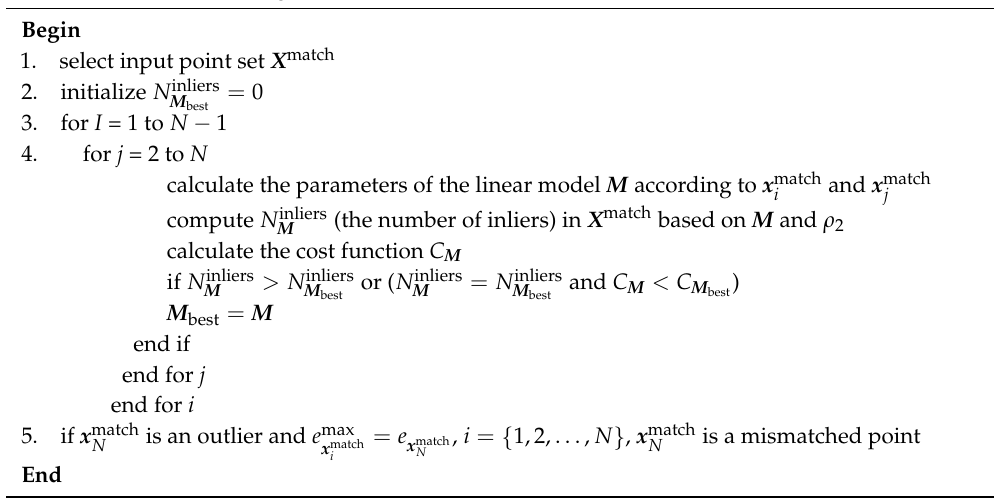
Algorithm 1. Model fitting